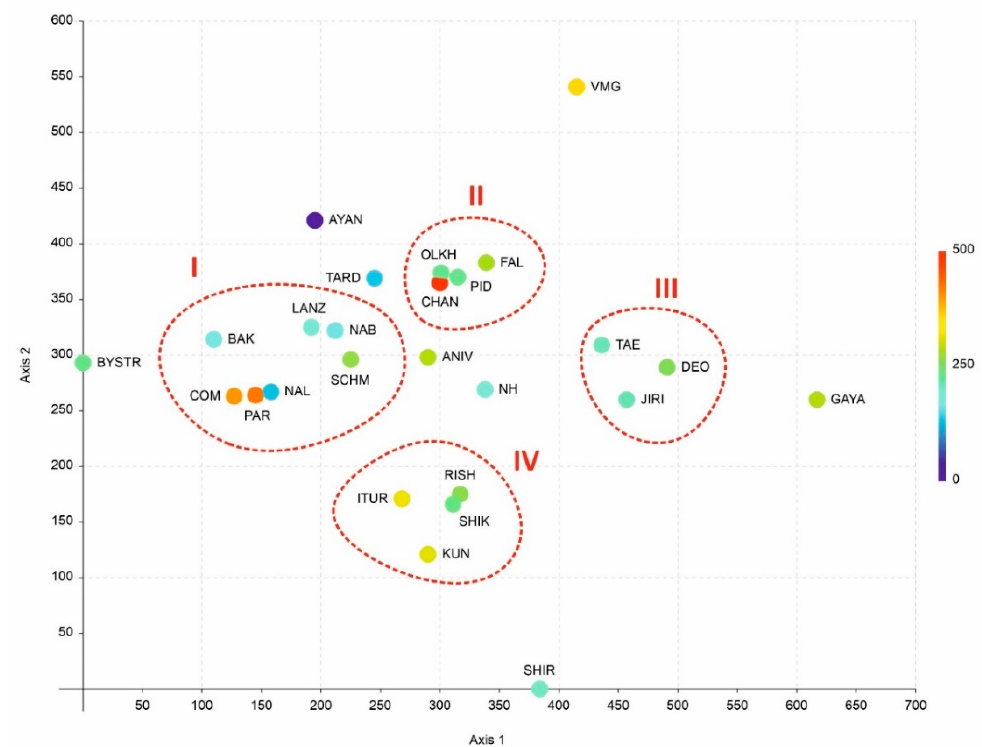
Figure 3. Comparison of the flora distribution in the DCA bubble chart (the third axis is the colour gradient from deep blue to deep red). Explanations on clusters are in the text and as following: